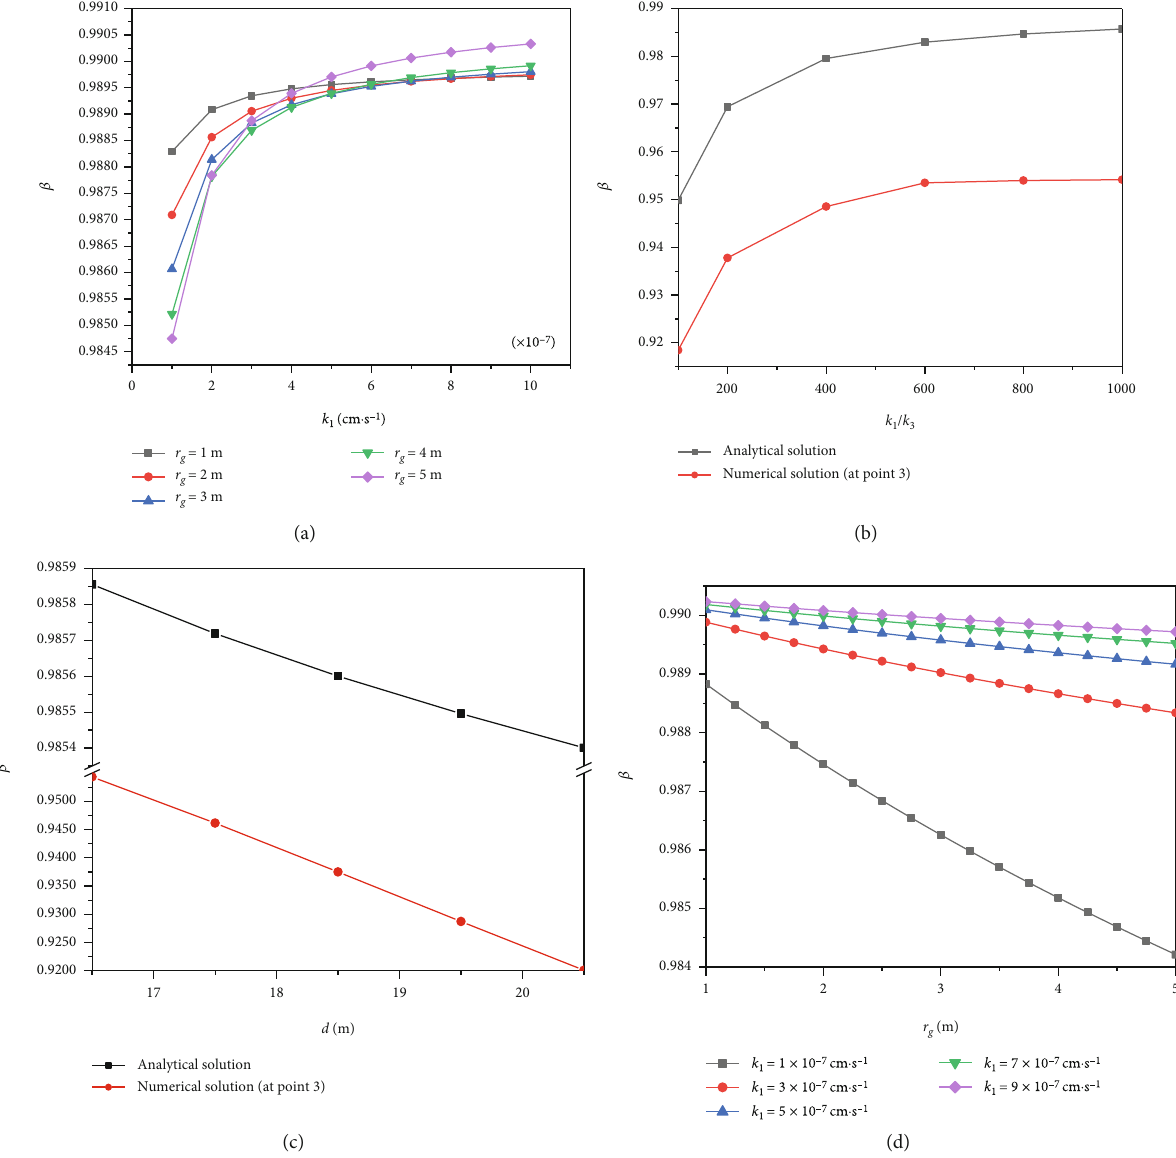
β and 1 . (b) Comparison of